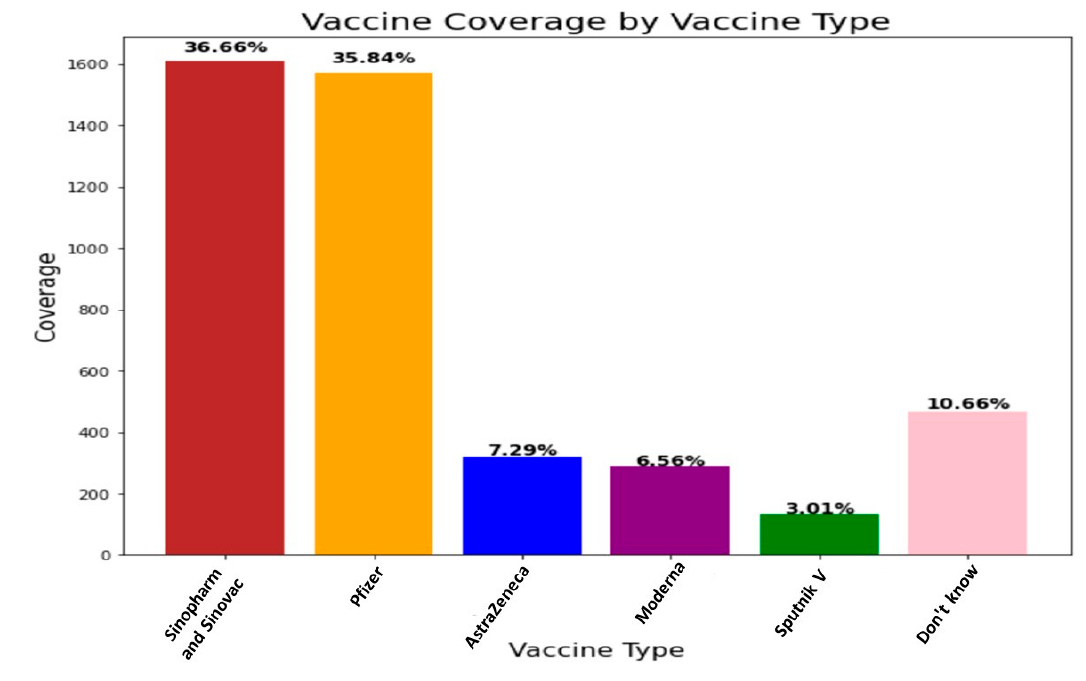
Figure 2. Participant’s response to Vaccine types.